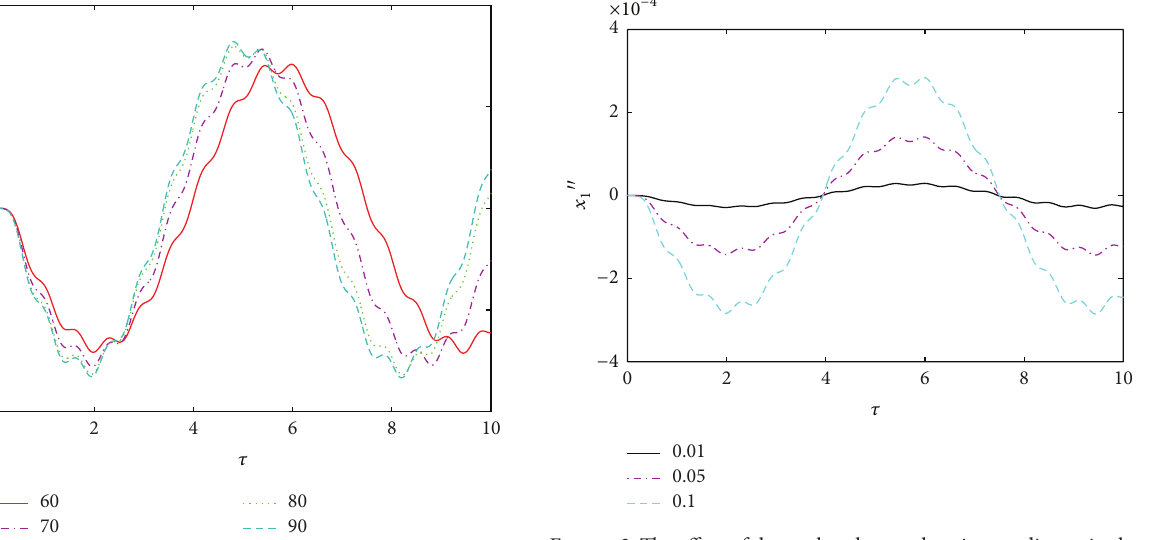
Figure 2: The effect of the angle of the tilted support spring on dimensionless acceleration response of critical components, where = 0.1 , 𝜆 = 10 , 𝜆 = 0.01 , and 𝜏 = 0.5 . 𝛽 ̈𝑢 0𝑚 1 2 0